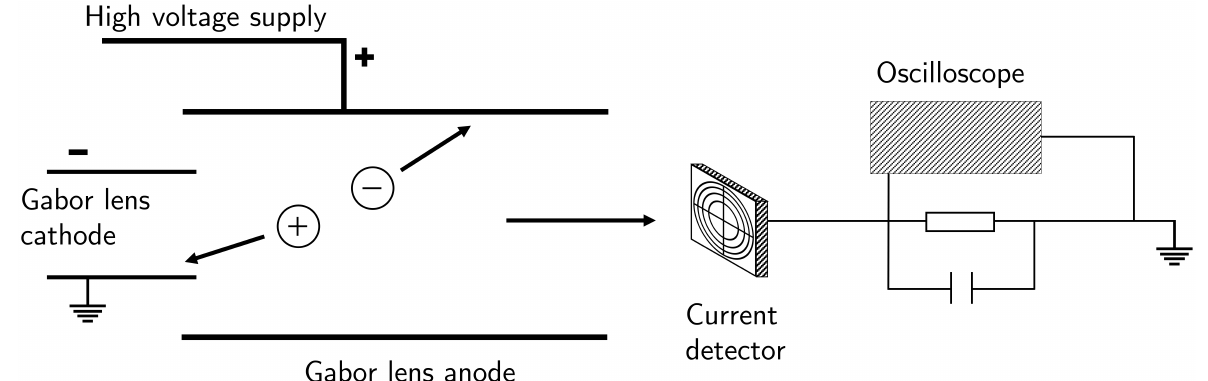
Figure 3. Schematic of the Gabor lens, current detector, and oscilloscope. The high voltage supply maintains the drop across the electrodes. Expelled ions hit the detector, and the current signal is converted to a voltage output signal in the oscilloscope.